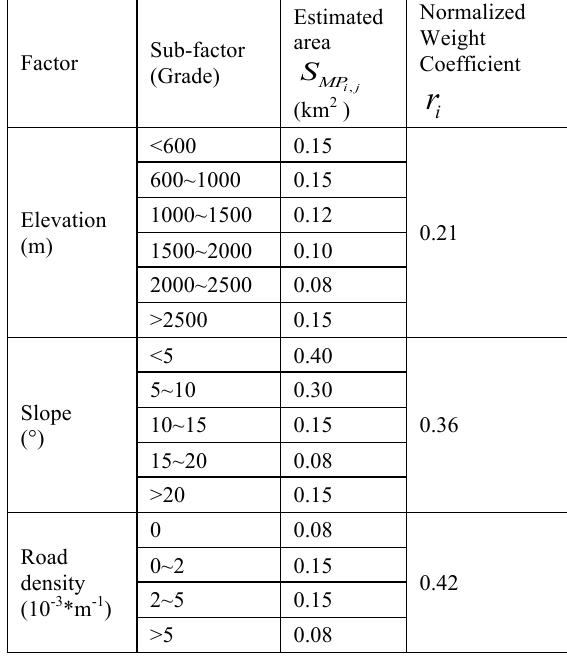
Table 2. Parameters of missing urban area